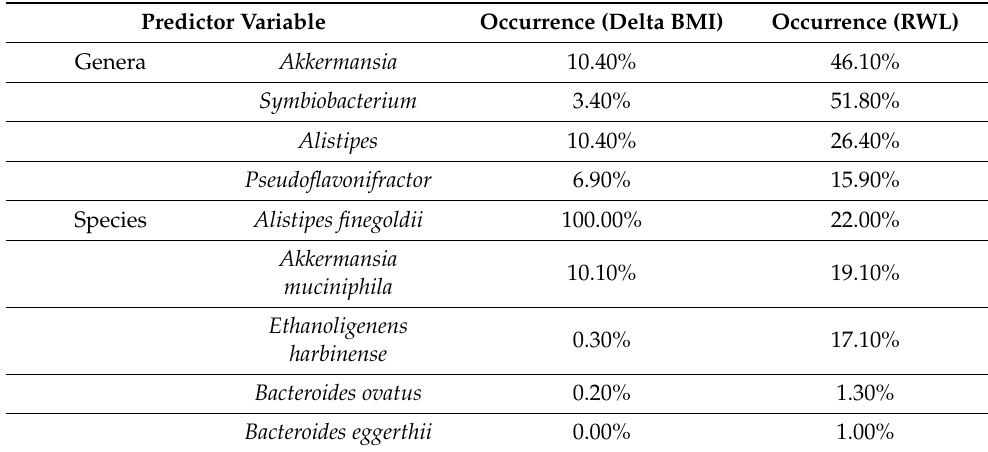
Table 2. Selection of genera and species predictor variables according to elastic net